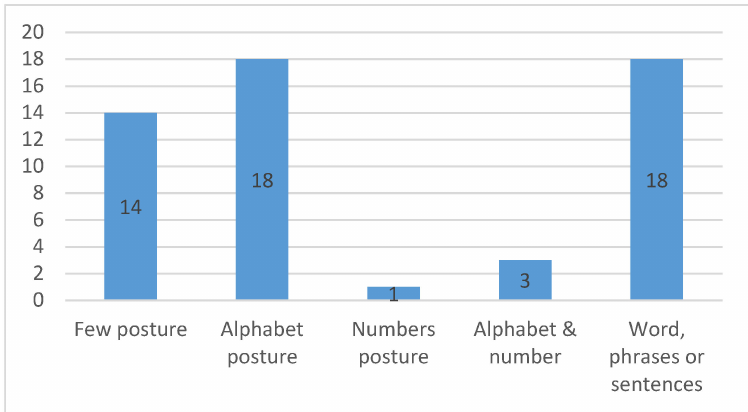
Figure 14. Number of articles on each variety of